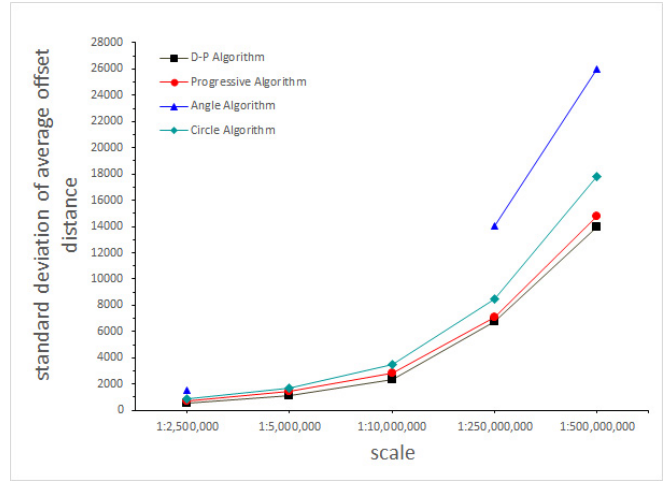
Figure 7. The standard deviation of average offset distance of the four simplification algorithms.